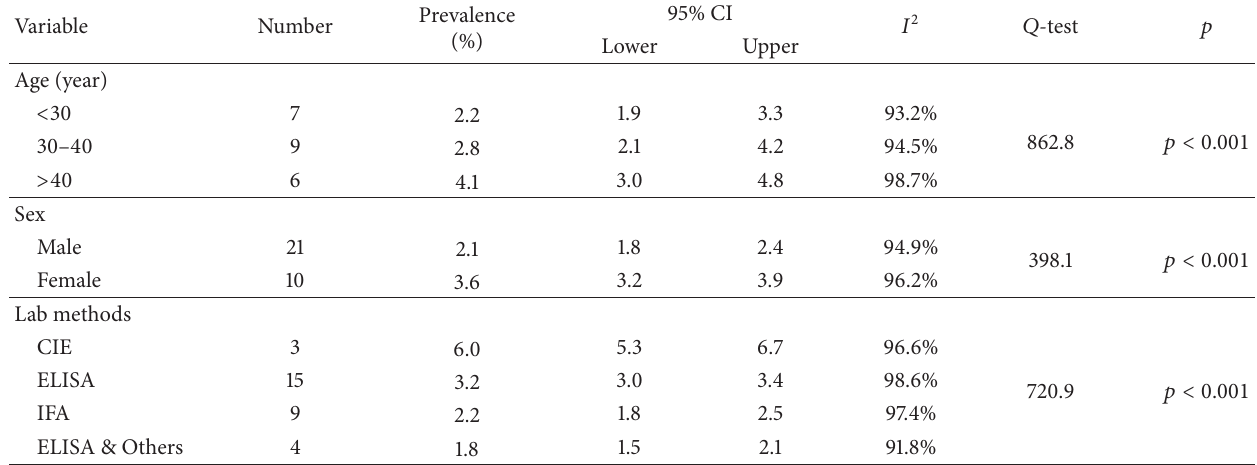
Table 2: Subgroup meta-analysis of cystic echinococcosis for age, sex, and lab